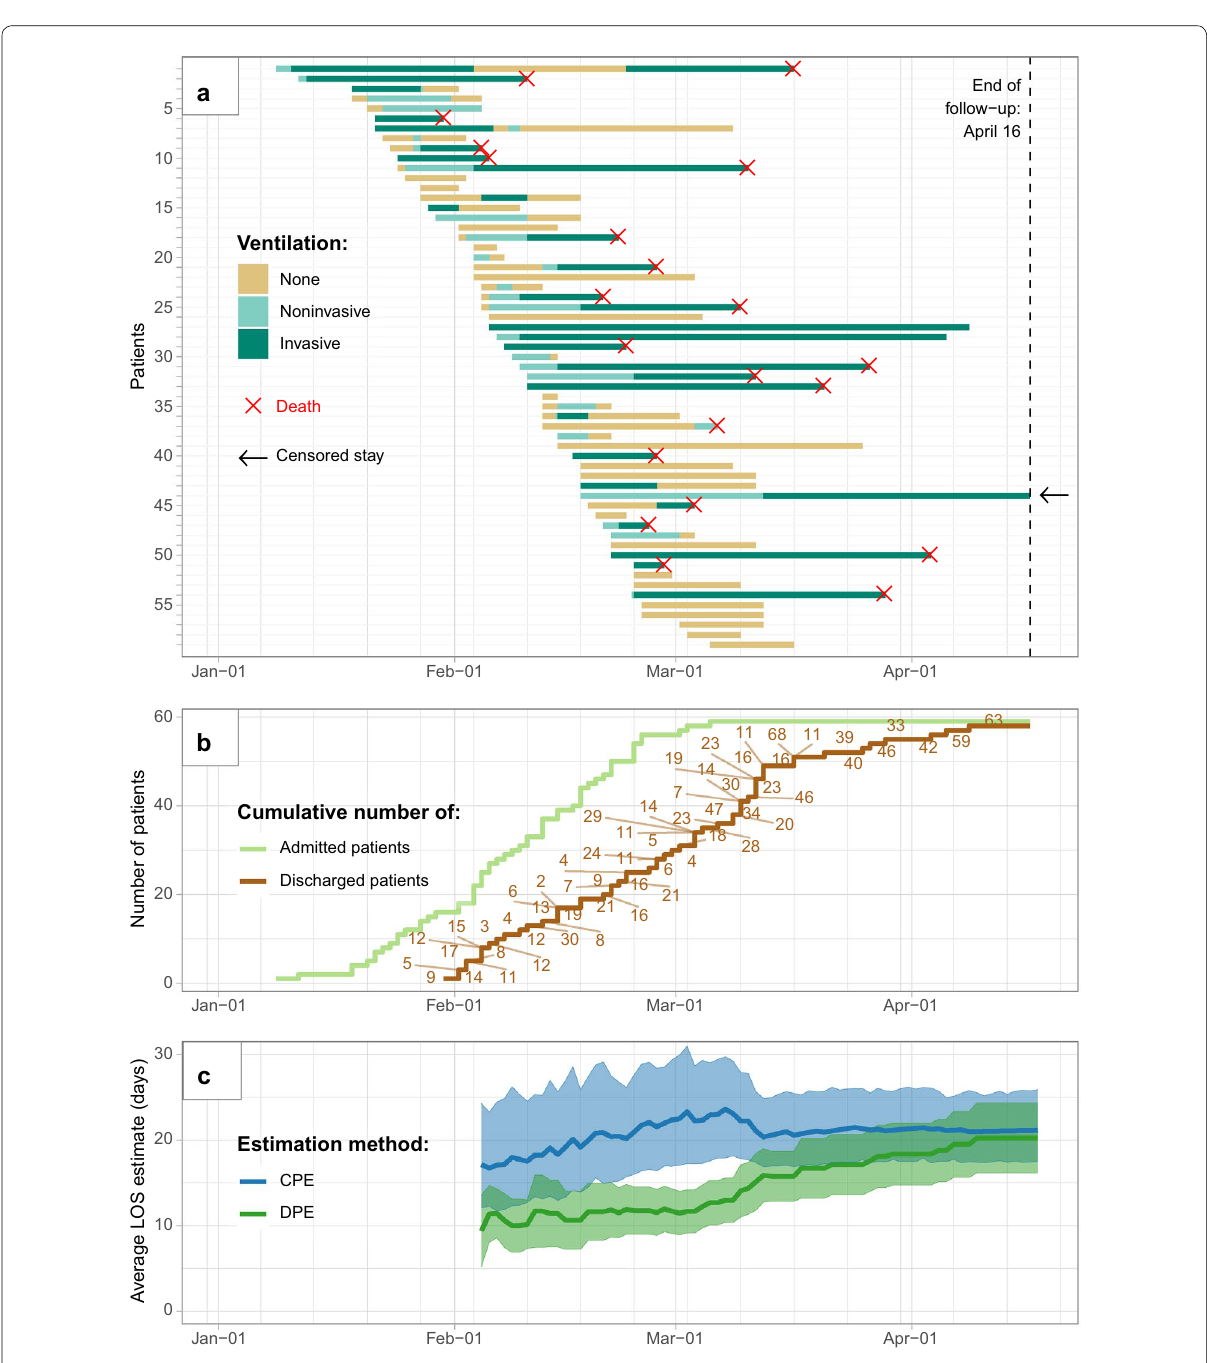
Fig. 1 Timeline of the 59 COVID-19 cases treated in the intensive care unit (ICU). a For each case are plotted admission and discharge dates, periods of ventilation, and vital status at discharge. b Cumulative numbers of admissions and discharges according to time, with discharged patients’ lengths of stay (LOS). c Evolution of the estimates of ICU average LOS issued from the two methods of estimation according to the date chosen for estimation. The expected estimate is shown together with the corresponding 95% confidence interval. CPE, method including censored cases; DPE, method considering only stays for which the patient was already discharged from ICU at the date of estimation. Whenever some patients of the cohort remain treated in the ICU at the date of follow-up, c indicates that DPE yields a biased underestimation of ALOS: discharges observed early are more likely to concern patients with a short LOS or conversely, the discharges occurring at the end of the process are more likely to concern patients with a long LOS. b illustrates the latter pattern: nine out of the 10 first occurring discharges concern LOS < 15 days, while eight out of the 10 last occurring discharges concerned LOS > 30